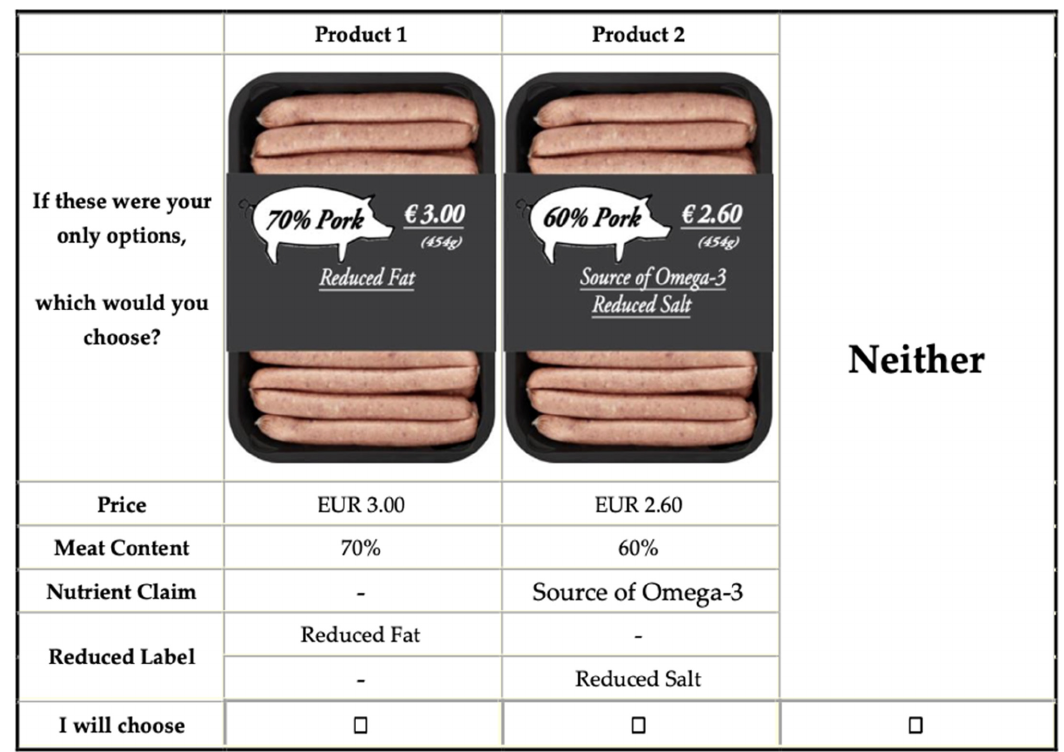
Figure A2. Choice set 2 in the questionnaire.